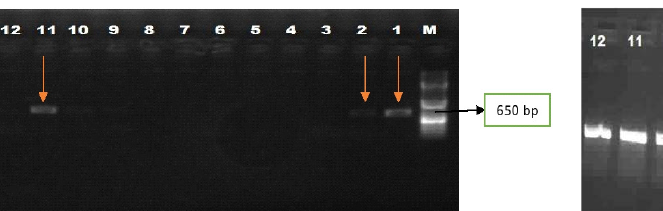
Fig. 3. Gel image of ITS primer amplified Inula gDNA’s by Phenol Choroform Isoamyl Alcohol Protocol1. I. anatolica , 2.